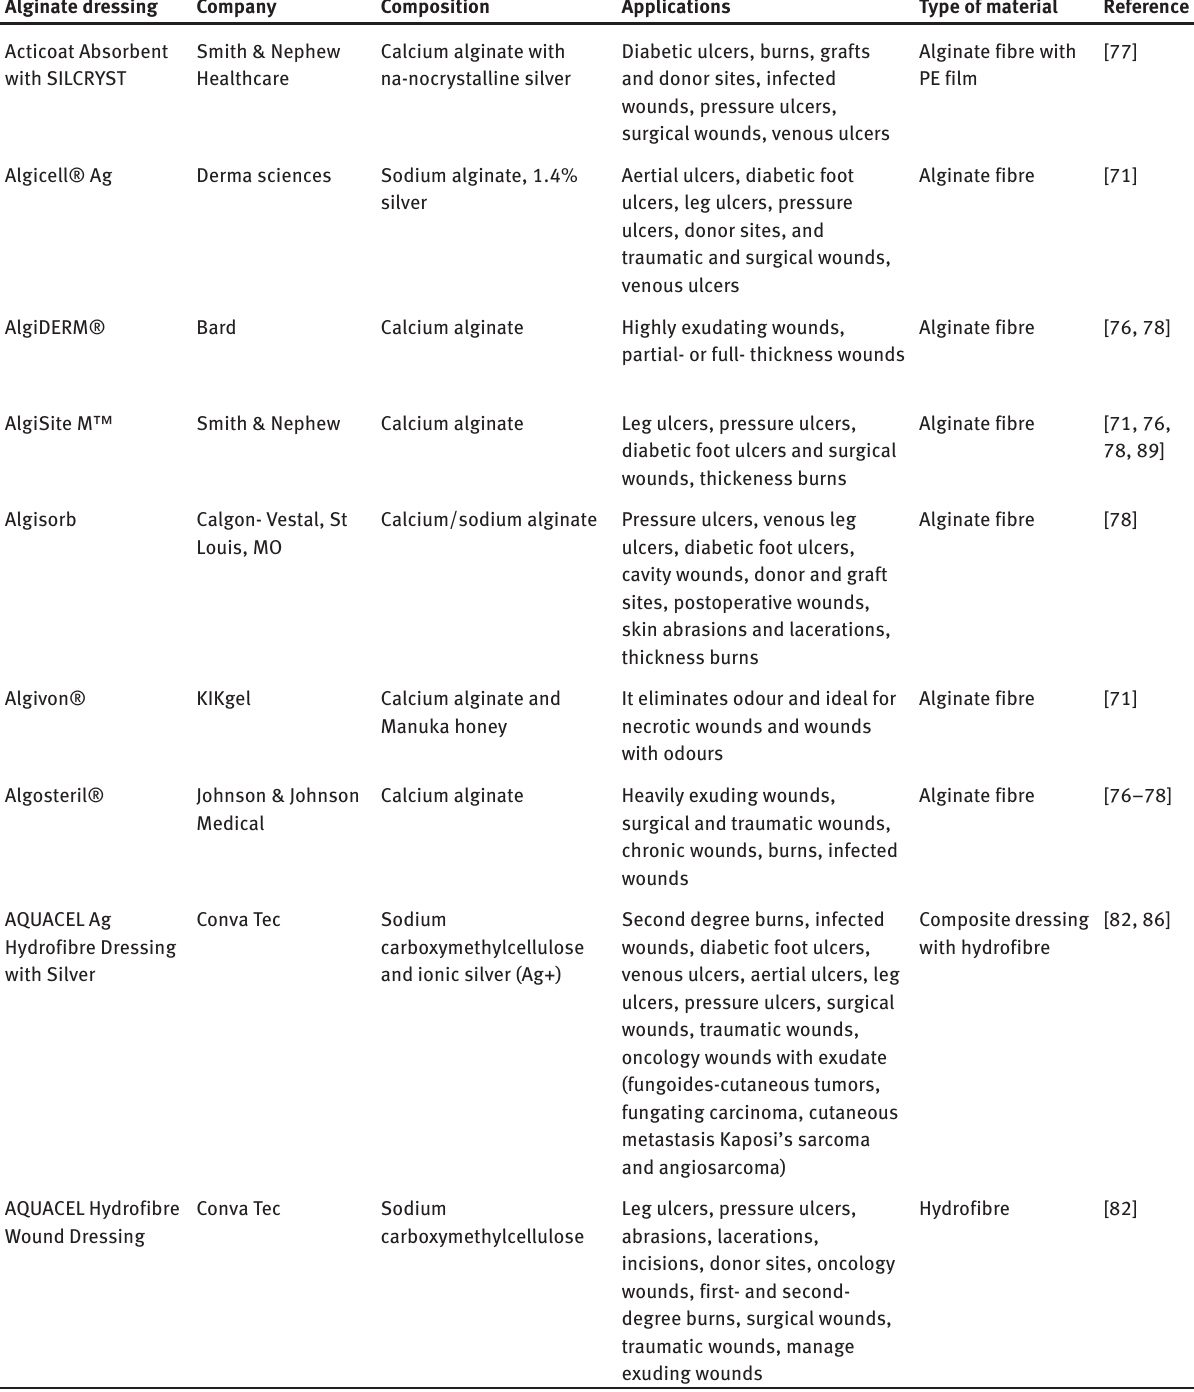
Table 3: Commercially available alginate- based wound